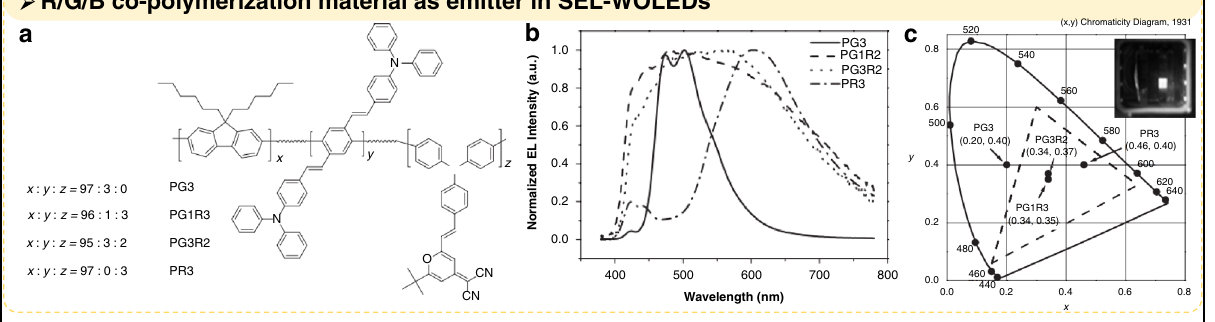
100 cd m − 2 . The white EL spectrum and the CIE coordi- nates as a function of voltage are shown in Fig. 7b, c.